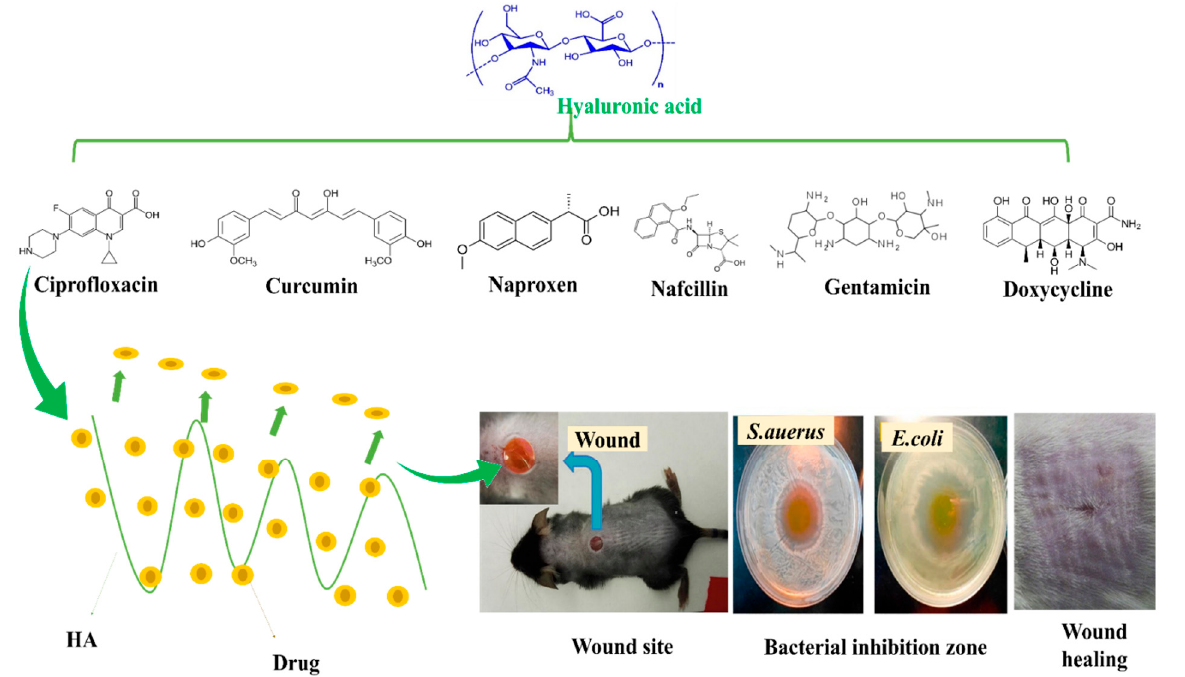
Figure 6. HA combined with different drugs; release at wound sites, bacteria mortality, and skin regeneration. Copyright 2017, Elsevier